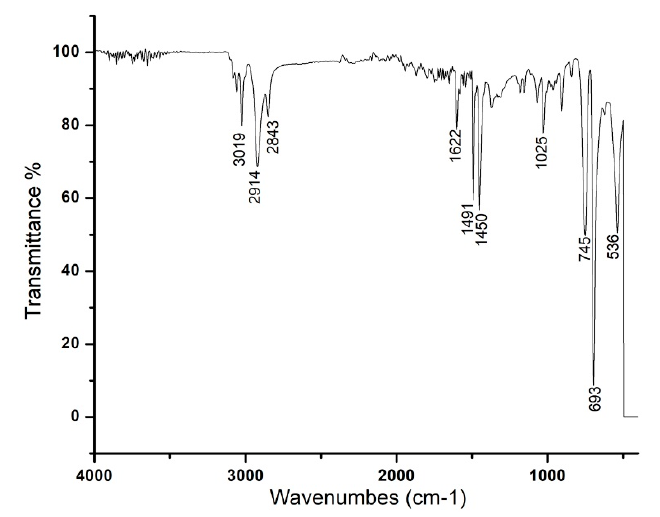
Figure 4. FT-IR spectra of the AuNPs phytofabricated by Ricinus communis leaf extract reduced with 1 mM solution of HAuCl 4 ·3H 2 O.